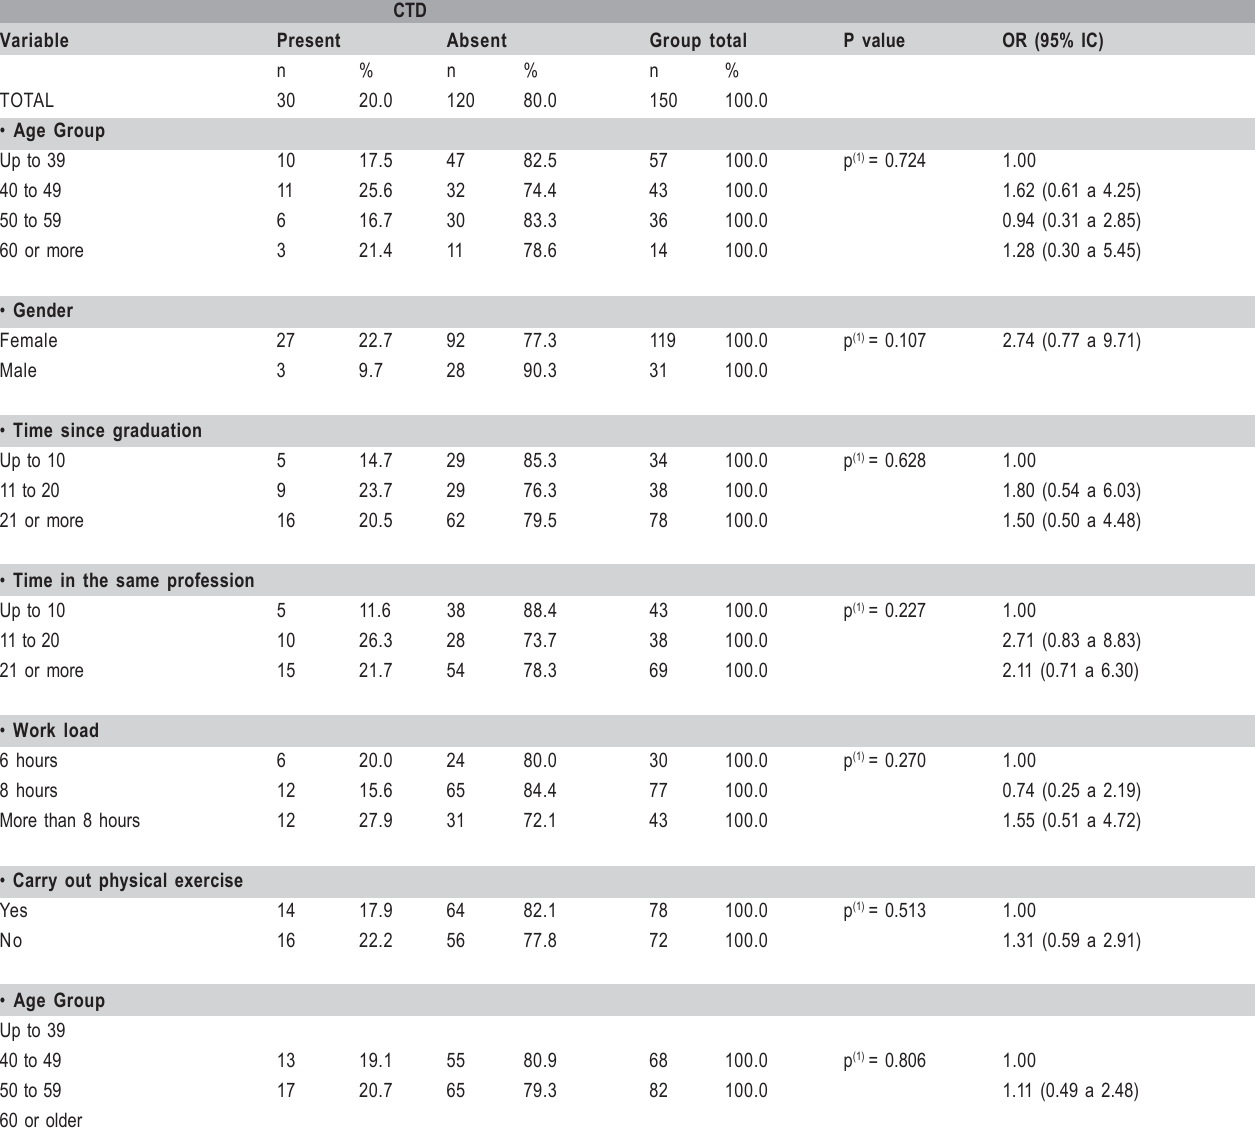
Table 2 - Evaluation of diagnosed CTD in the past 12 months according to age, gender, time since graduation, time in the same occupation, working hours, physical exercise and